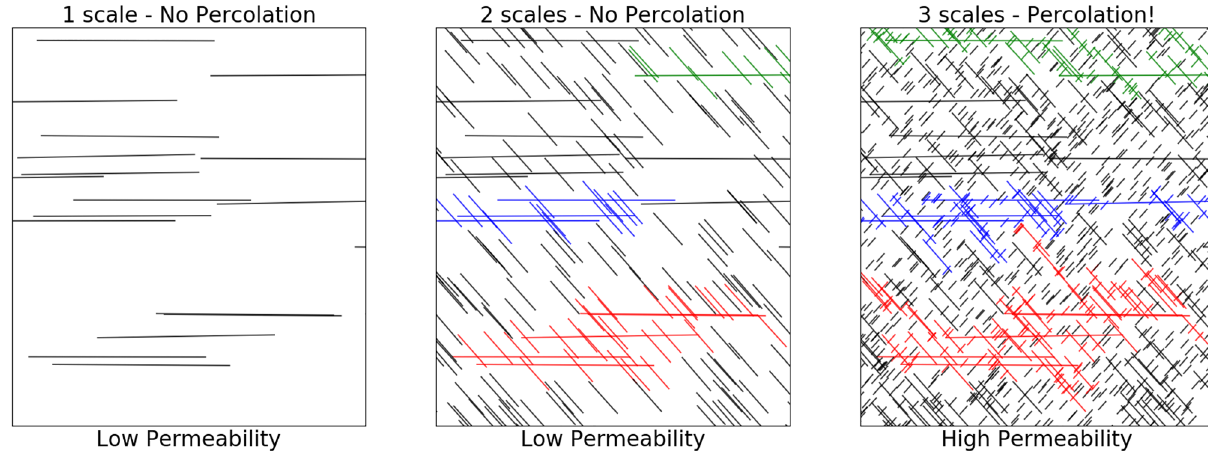
Figure 2. Fracture systems feature critical behavior, such as percolation, which is only apparent when taking many length scales in to account. Here we give a simplified conceptual diagram of the heirarchical structure of fracture networks. This model highlights how percolation, which has a large impact on effective permeability, is the result of many fractures of different lengths intersecting (here all fractures are represented as lines in two dimensions and we do not explicitly model the width or aperture). The red/blue/green colors indicate connected components in the fracture network—the blue connected component in the right image results in